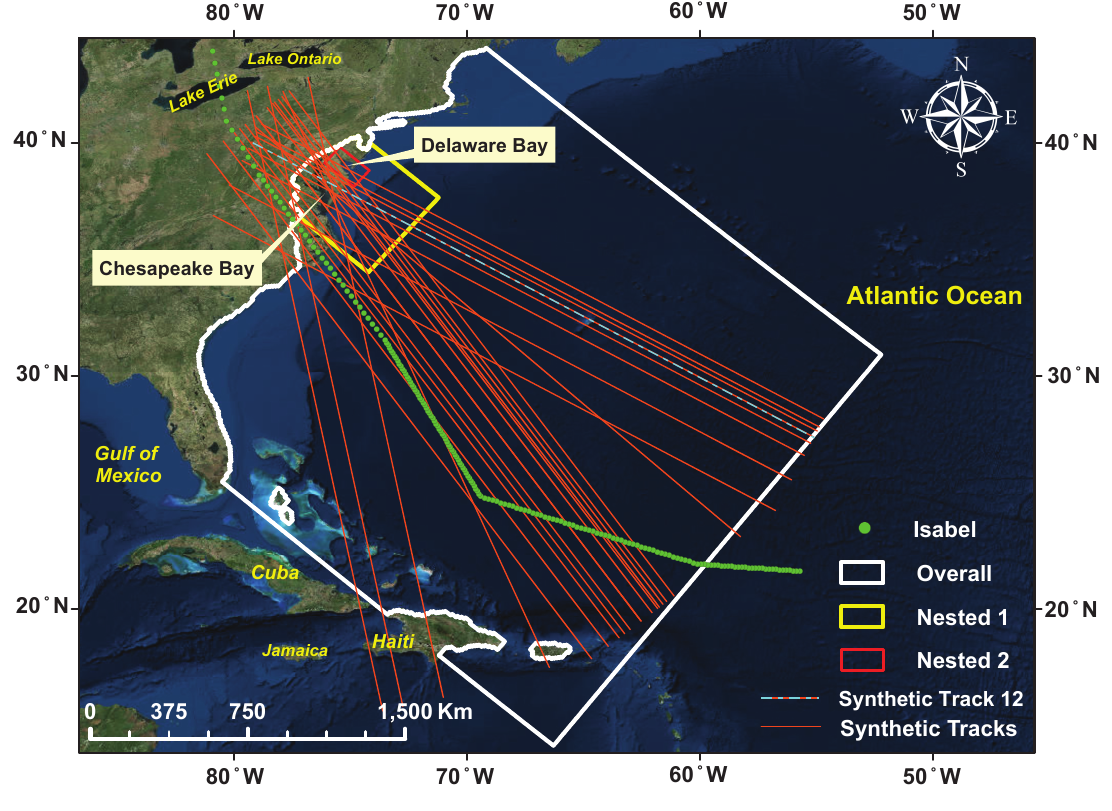
Figure 2. Location map for the extent of three model domains. Hourly location of hurricane Isabel shown in green solid circles. Orange lines present synthetic hurricane